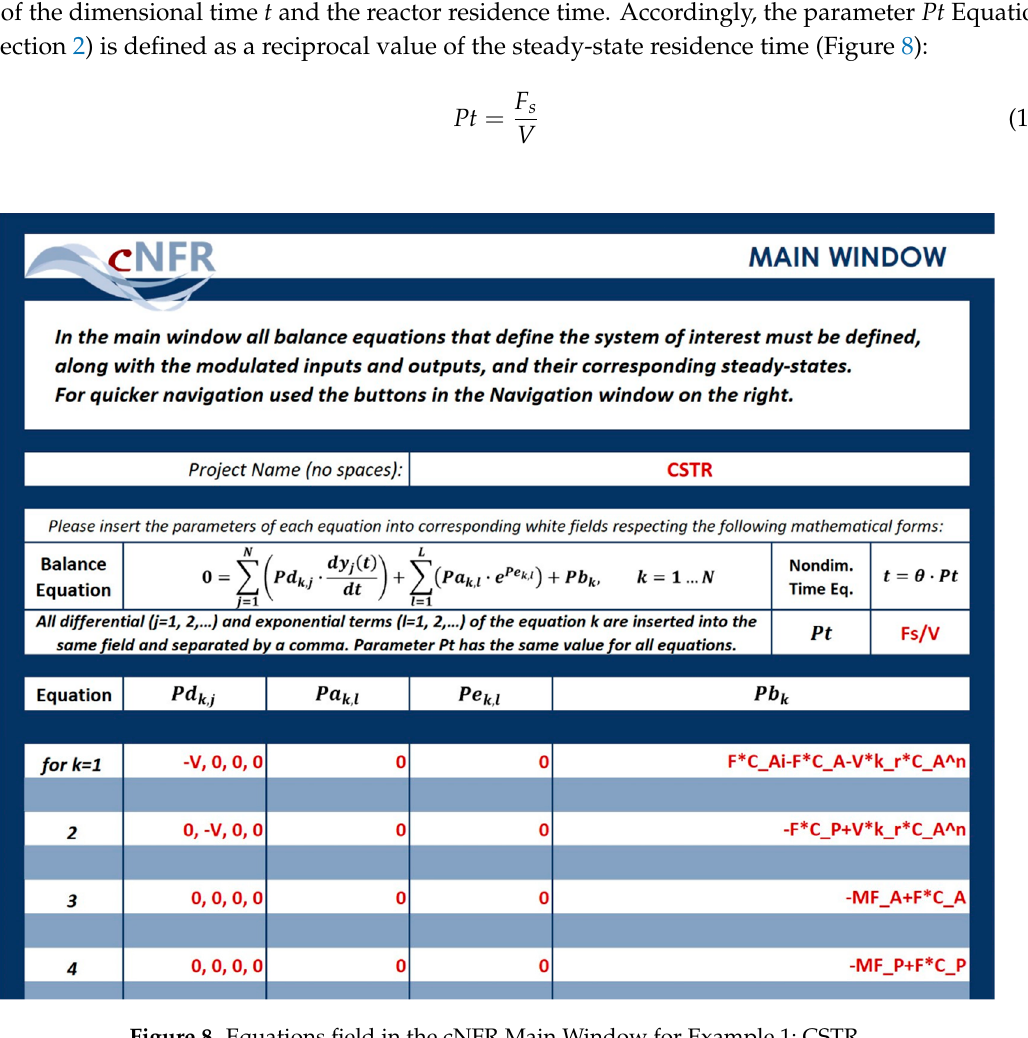
Figure 8. Equations field in the cNFR Main Window for Example 1: CSTR.